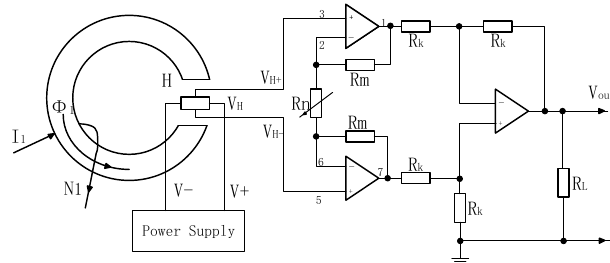
Figure 22. The schematic diagram of Leakage current detection.